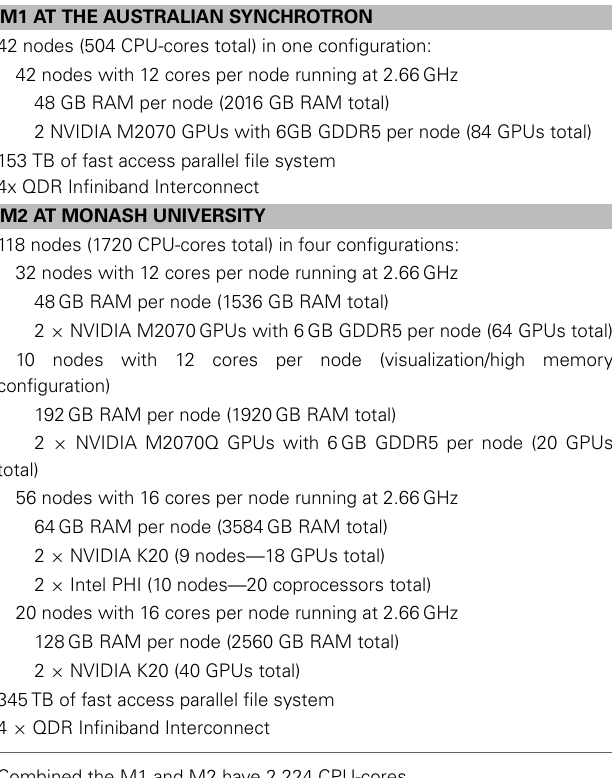
Table 1 | Technical specifications of the MASSIVE high performance computing